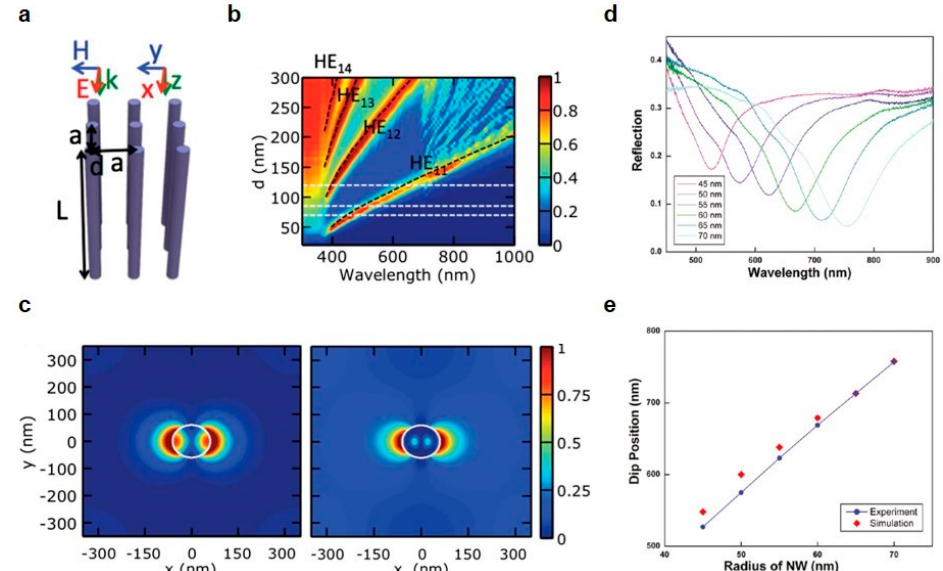
Figure 1. ( a ) Schematic of the vertically aligned nanowire array. ( b ) Absorption graph on the basis of wavelength and diameter of Si nanowire. ( c ) Contour maps of the electric field intensity of leaky mode resonances for vertical nanowire (d = 120 nm) at the wavelengths of (left) 670 and (right) 400 nm which accord with the HE (cid:2869)(cid:2869) and HE (cid:2869)(cid:2870) modes, respectively. Both are the top view of |𝐄(𝐫)| (cid:2870) at 0 nm in the z-axis. ( d ) Measured reflection spectra of nanowire arrays with different radii. The spectral graph shows the redshift of the spectral dip as the nanowire diameter increases. ( e ) Comparison of the measured and simulated spectral dip positions according to the changes of nanowire radius. ( a – c ) reprinted with permission from [36]. Copyright 2012 The Optical Society; ( d , e ) reprinted with